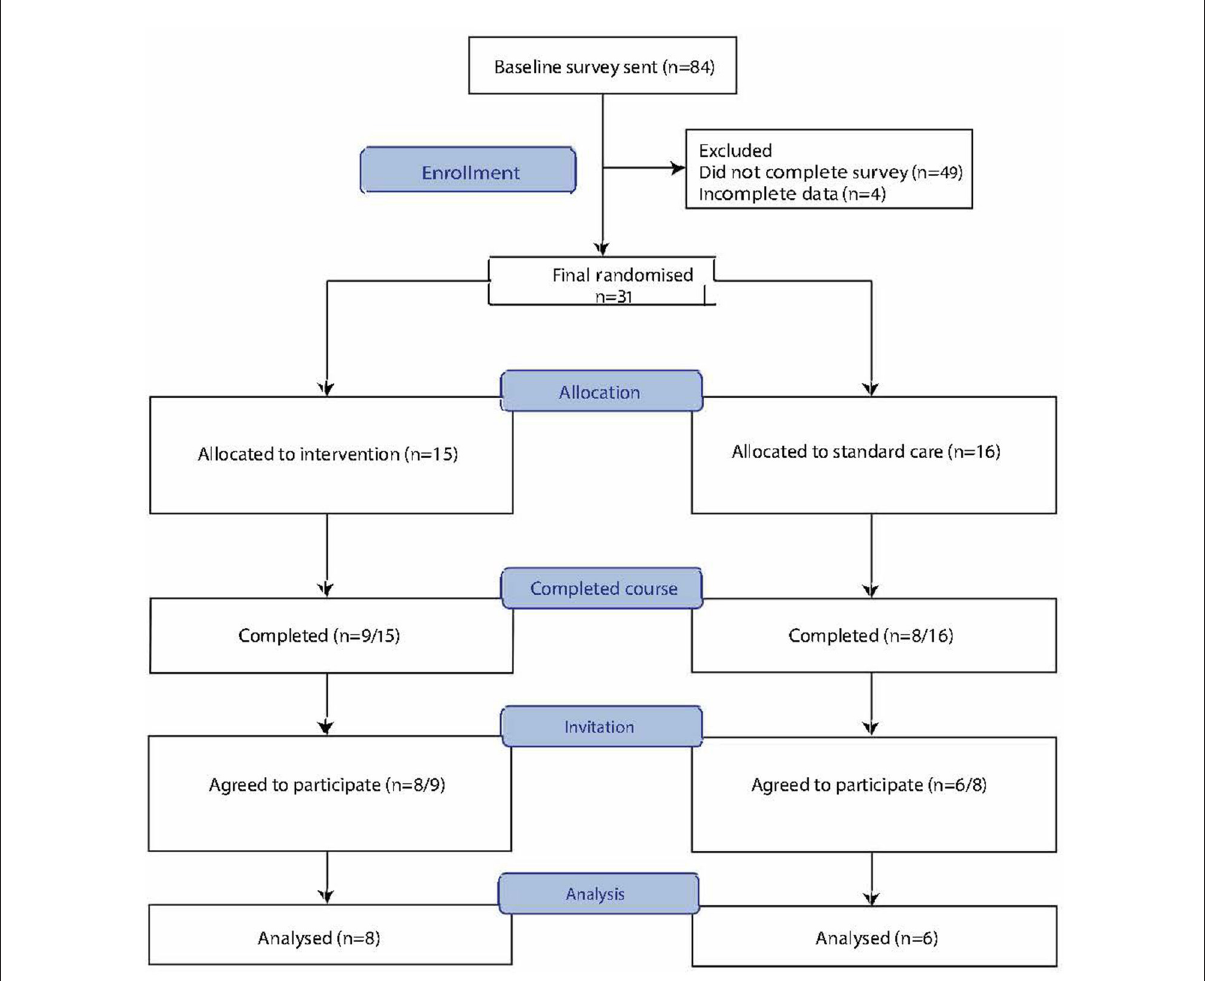
FIGURE1 Consort flow diagram of participant recruitment for the multiple sclerosis online course feasibility randomized controlled